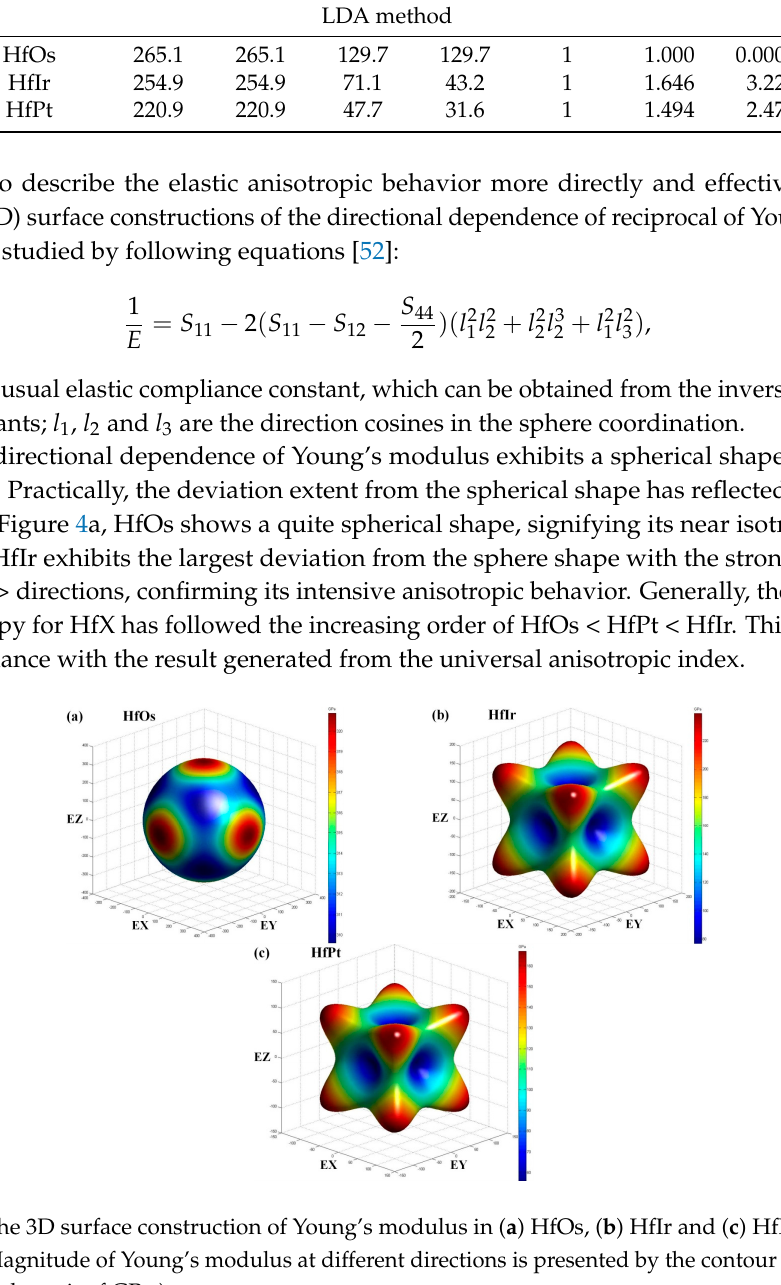
Table 4. The calculated Voigt and Reuss bounds for bulk (shear) modulus, and universal anisotropic index ( A U ) for HfX (X = Os, Ir and Pt). Compounds B V